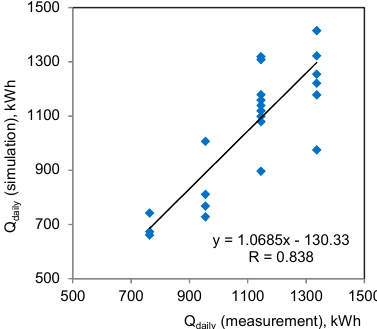
Figure 5. Correlation of measured and calculated daily heat demand in the validated period (excluding Mondays) for the school building.